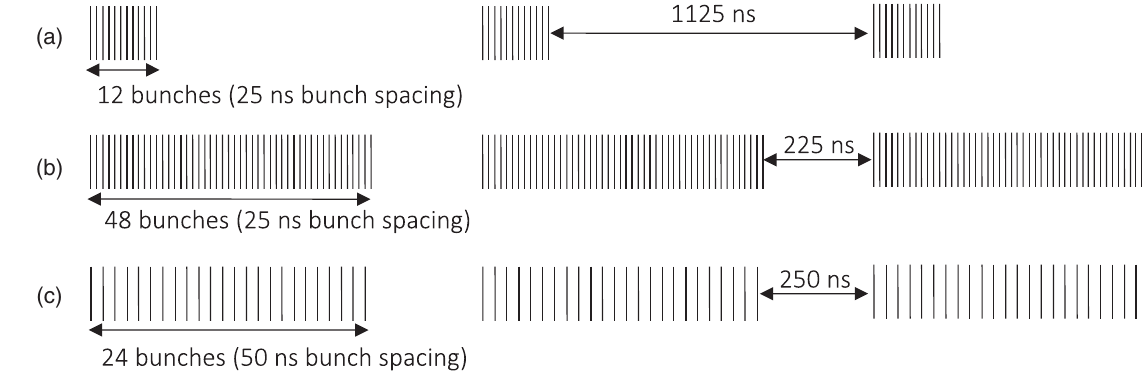
FIG. 12. The schemes of the first three batches are presented for the three fills: (a) fill 5717, (b) fill 5887, (c) fill 5980.